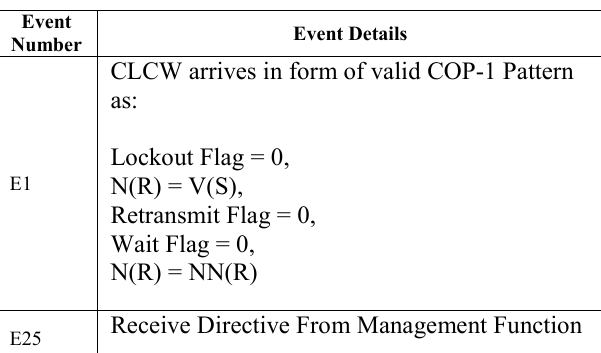
Figure 8. A Sample State Transition Diagram Table 1. Event